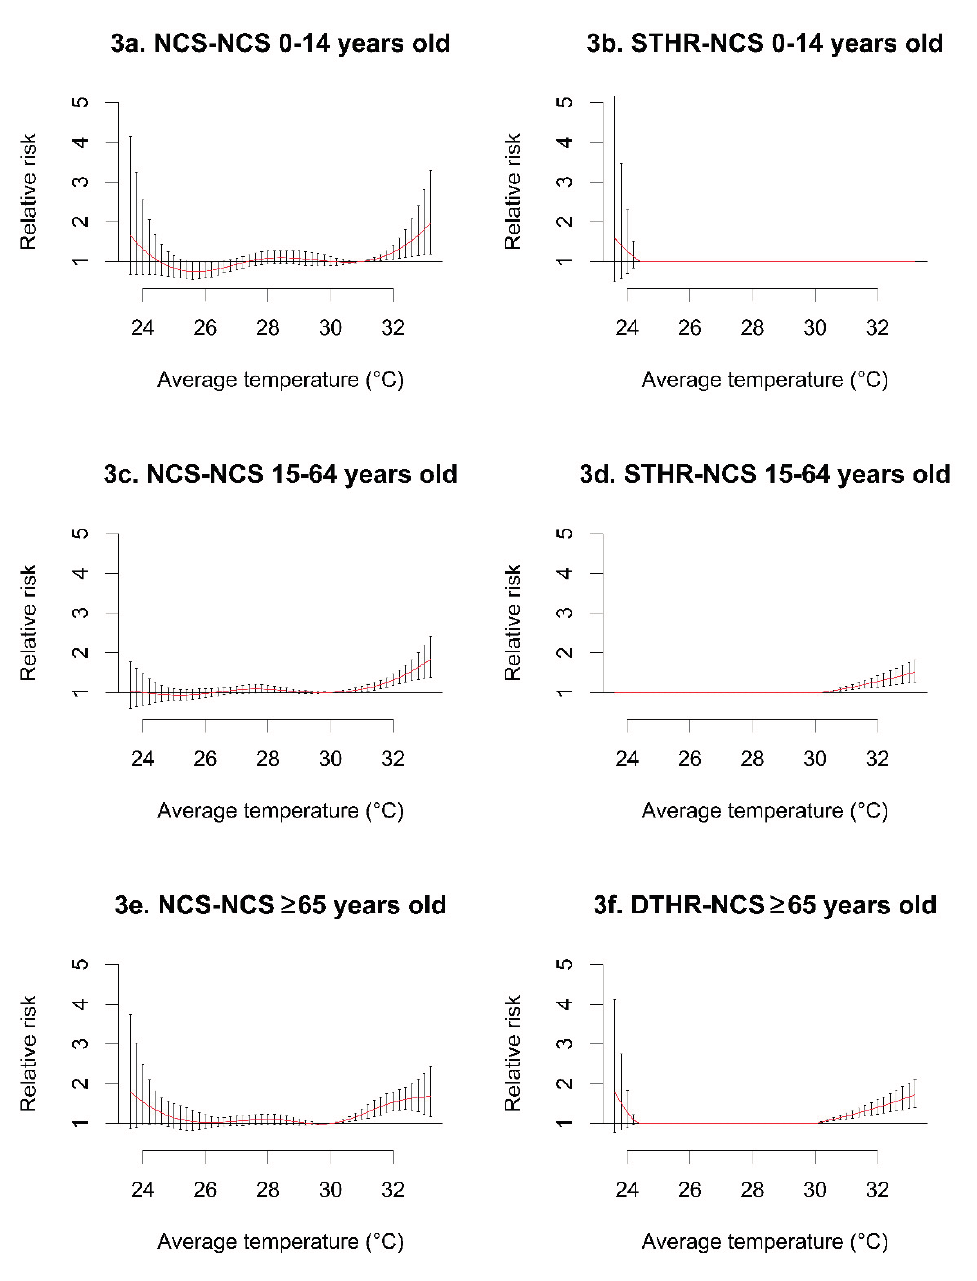
Figure 3. Age-related relative risk in the NCS-NCS, DTHR-NCS, and STHR-NCS models. Only the ≥ 65 year old category ( e–f ) required a DTHR-NCS model, because of its prominent low and high temperature effects. All other age groups were reduced to STHR-NCS as their final form, with the 0–14-year-old age group ( b ) exhibiting a pronounced lower temperature effect. NCS: natural cubic spline, STHR: single high threshold, DTHR: double high